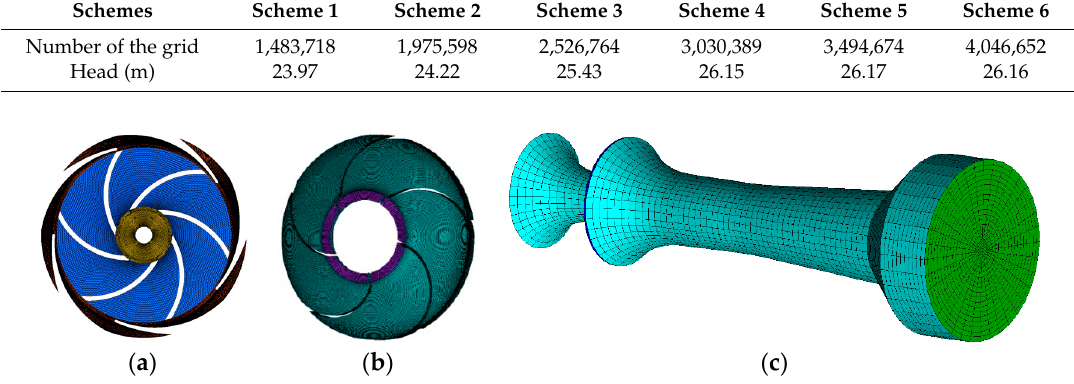
Figure 2. Grid diagrams of the impeller, guide vane, and jet. ( a ) Impeller; ( b ) Guide vane; ( c ) Ejector nozzle and tube.